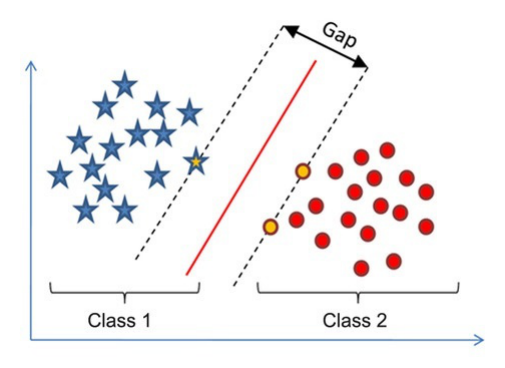
Figure 2. Classification